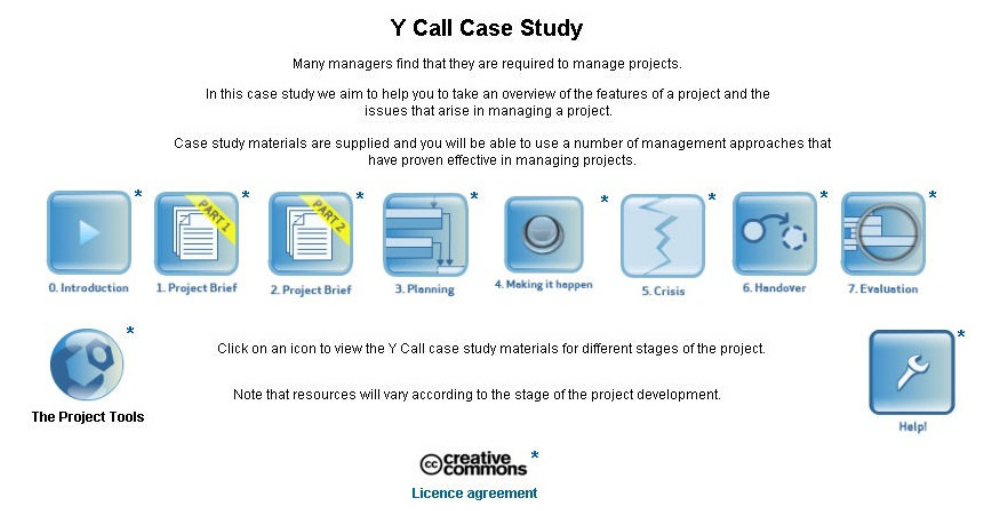
Figure 12 . “Front page” Compendium map for the Project Management study